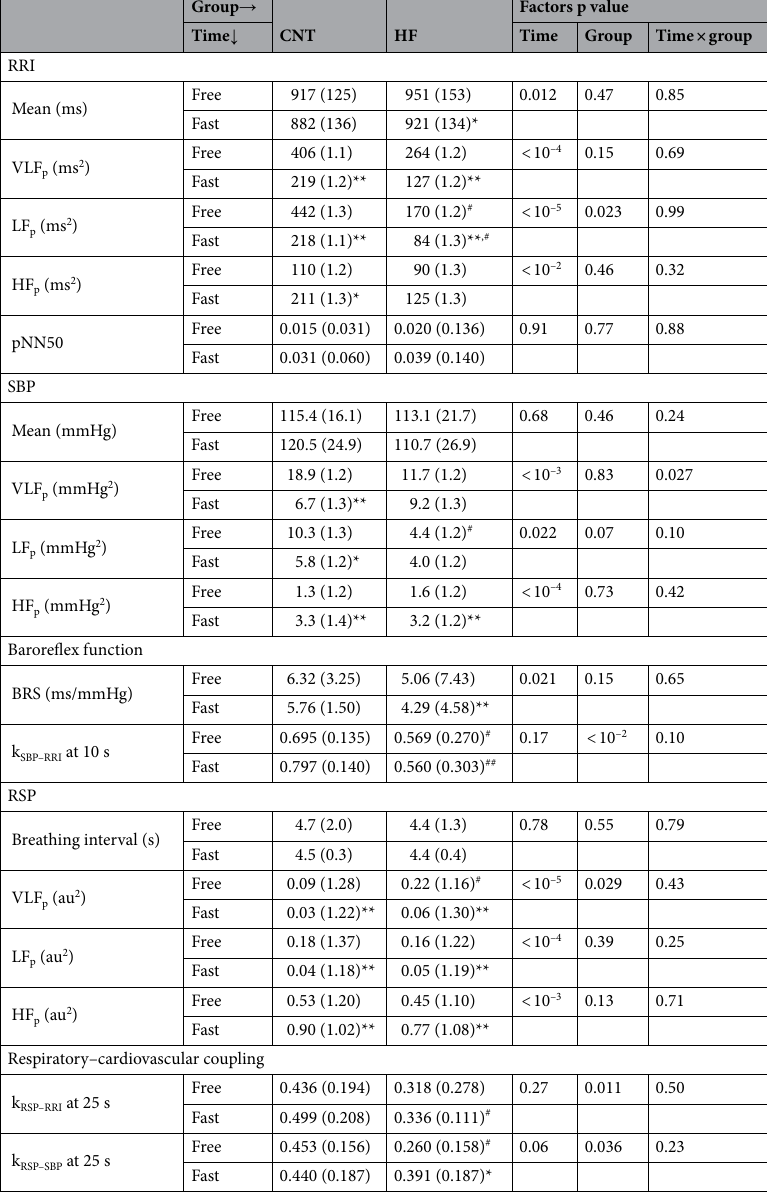
Table 2. Cardiovascular and respiratory indexes in free vs. fast-paced breathing by group, with factors significance. Significance by ANOVA and by ANOVA on ranks for BRS and pNN50; post-hoc analysis by Fisher’s LSD: the * and ** indicate significant differences between times at p < 0.05 and < 0.01; the # and ## indicate significant differences between groups at p < 0.05 and < 0.01; RRI mean, SBP mean and breathing interval as mean (SD); powers as geometric mean (geometric SD); pNN50 and BRS as median